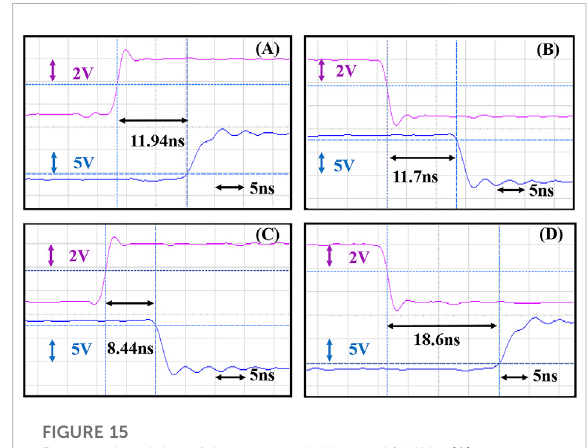
Propagationdelayoftheproposeddriverat10 MHz: (A) turn- on delay of the high-side driver; (B) turn-off delay of the high-side driver; (C) turn-on delay of the low-side driver; (D) turn-off delay of the low-side driver.